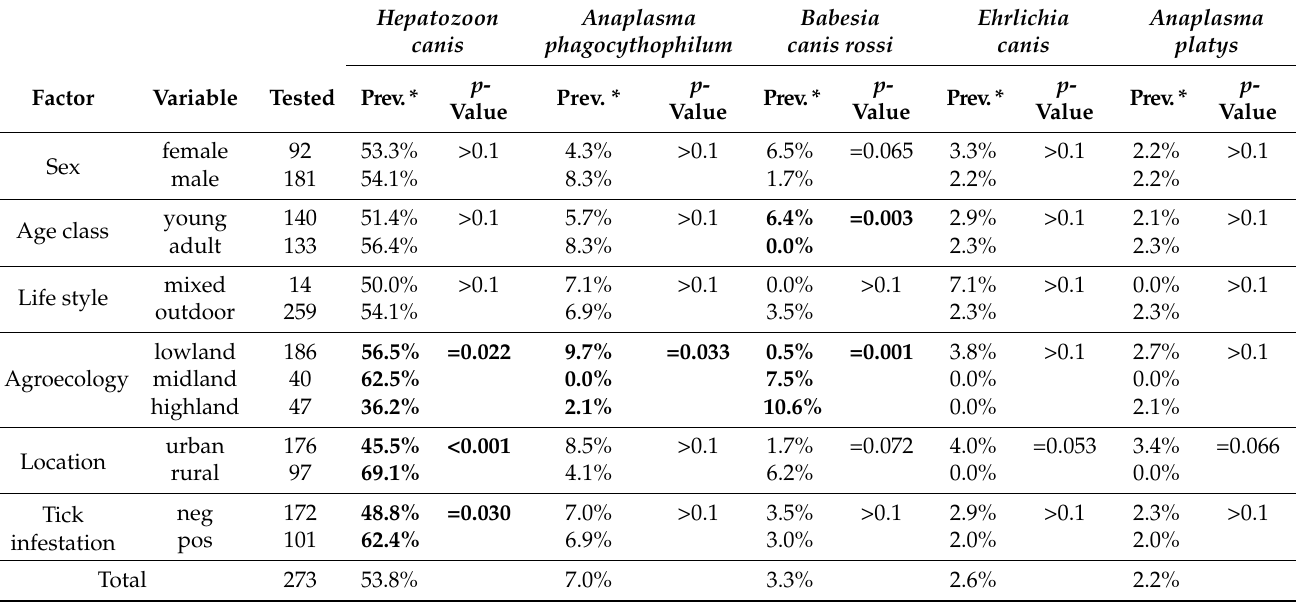
Table 2. Distribution of positivity in the investigated dog population according to different factors.